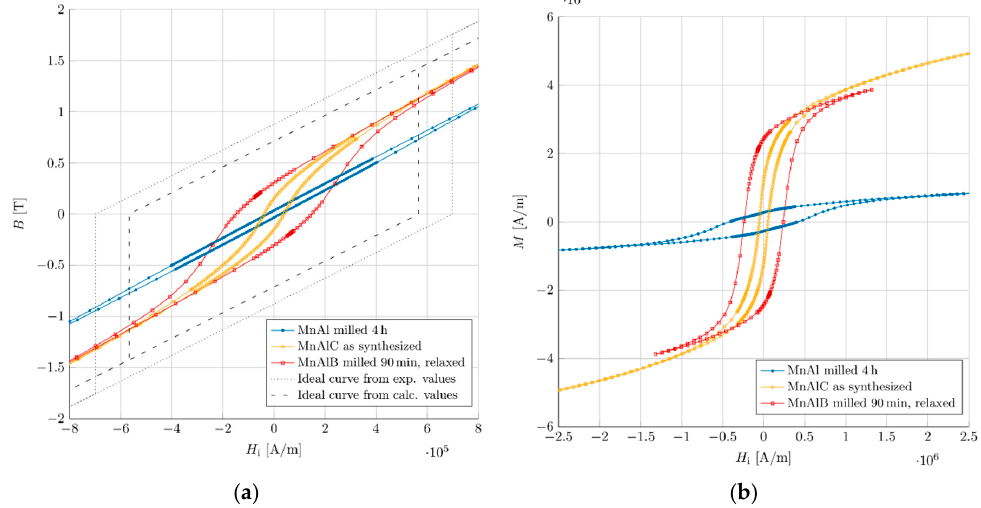
Figure 3. Hysteresis curves of the MnAl samples: ( a ) B vs. H i curves; ( b ) M vs. H i curves. Table 2. Magnetic properties of calculated MnAl and experimental MnAl with an addition of carbon and boron.